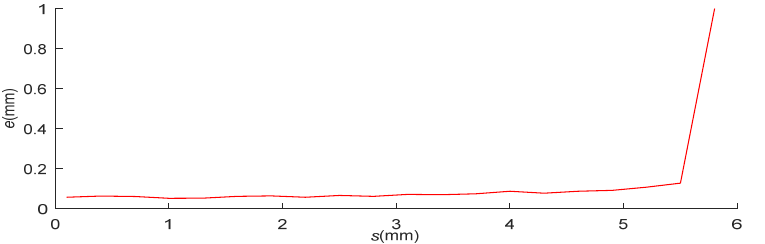
Figure 26. Detection error versus acceleration displacement of the pose measurement system.